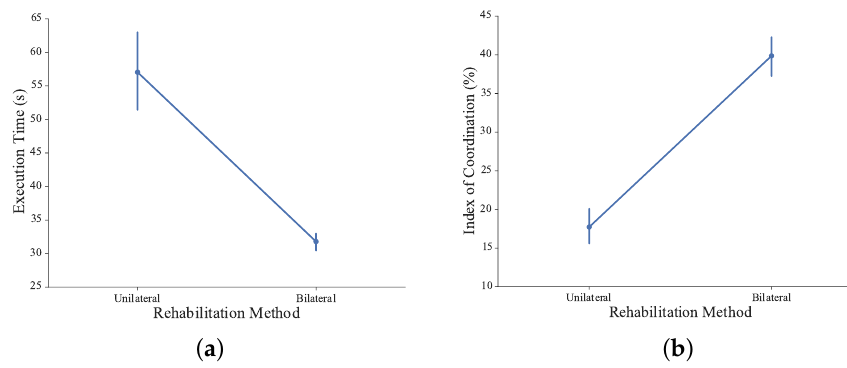
Figure 17. ( a) Comparison of execution time between the unilateral and bilateral methods; ( b ) Comparison of the index of coordination between the unilateral and bilateral